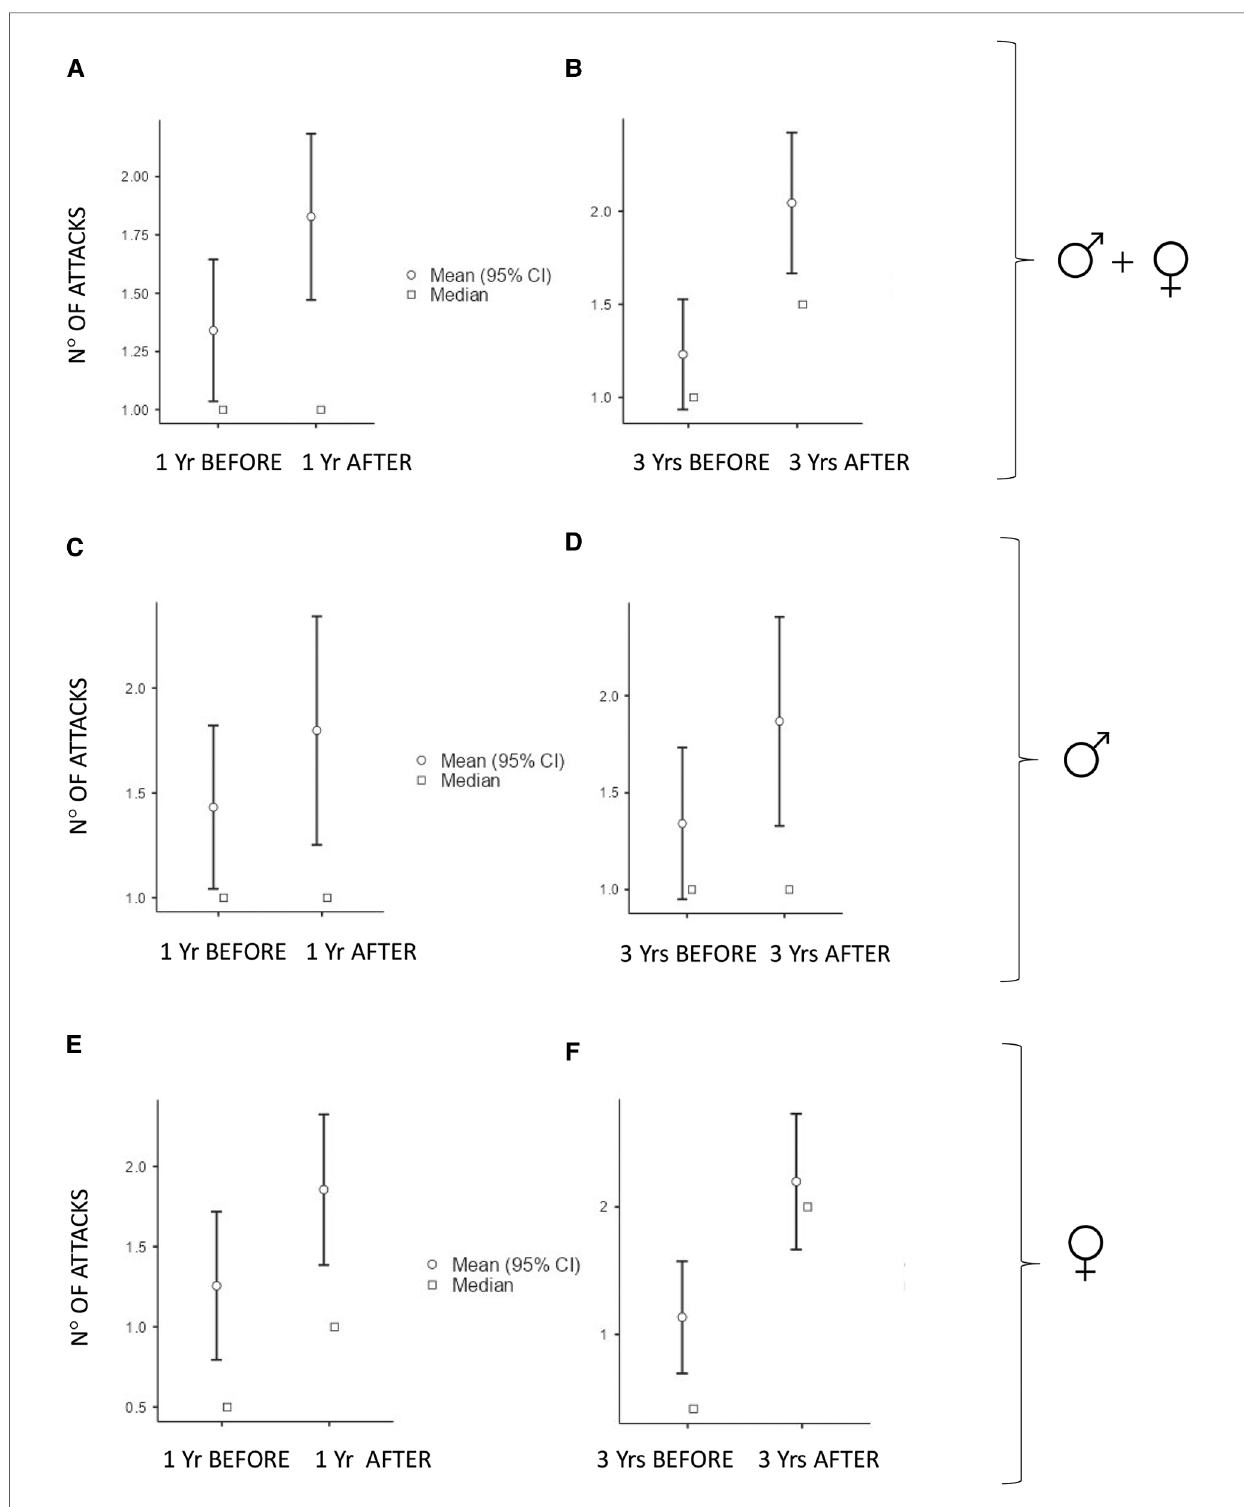
FIGURE 1 Number of monthly mean of attacks 1 year (Yr) before vs. 1 year after puberty and 3 years (Yrs) before vs. 3 years after puberty: In all the subjects: ( A ) median (IQR)=1 (2) vs. 1 (2.75), p <0.001 and ( B ) median (IQR)=1 (2) vs. 2 (2.42), p <0.001. In males: ( C ) median (IQR)=1 (1.92) vs. 1 (2.65), p =0.035 and ( D ) median (IQR)=1 (1.92) vs. 1.25 (1.56), p <0.001. In females: ( E ) median (IQR)=0.5 (2) vs. 1 (2.46), p =0.004 and ( F ) median (IQR)=0.41 (2) vs. 2 (2.17), p